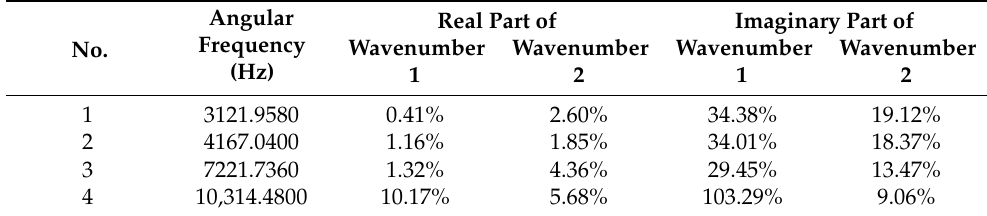
Table 4. The deviation rate relative to the test wavenumber.